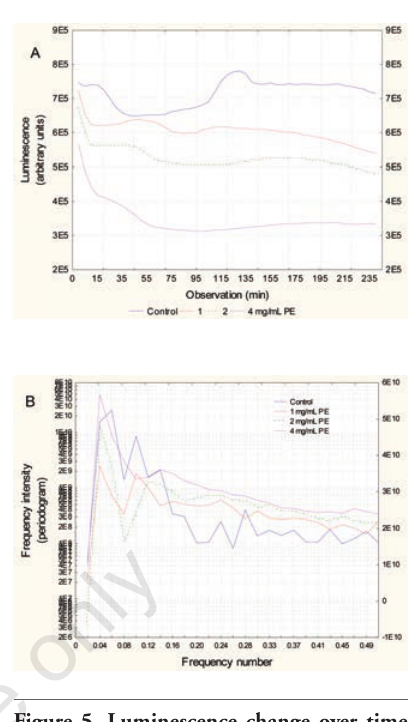
Figure 5. Luminescence change over time in bacteria exposed to microplastic beads (1-3 um). Bacteria were re-suspended at 20 million cells/mL in 2% NaCl containing increasing concentrations of polyethylene microplastic beads. Luminescence was recorded at 5-min intervals for 3 h at 20°C under constant agitation. Recorded lumi- nescence at each time (A) and frequency analysis by Fourier transformation (B) are shown.